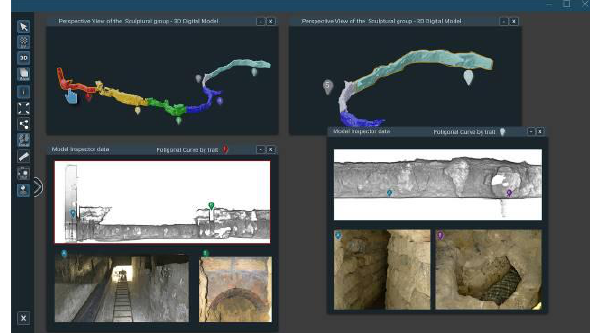
Figure 14 . UnReal Engine interface, integrated navigation mode. The geo-referencing of the 3D model with infographics and 2D documentation, through reference tags.